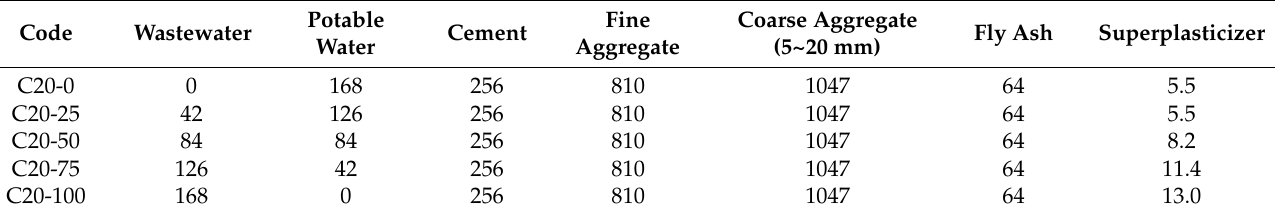
Table 5. Freeze–thaw cycle mix proportions of C20 concrete (kg/m 3